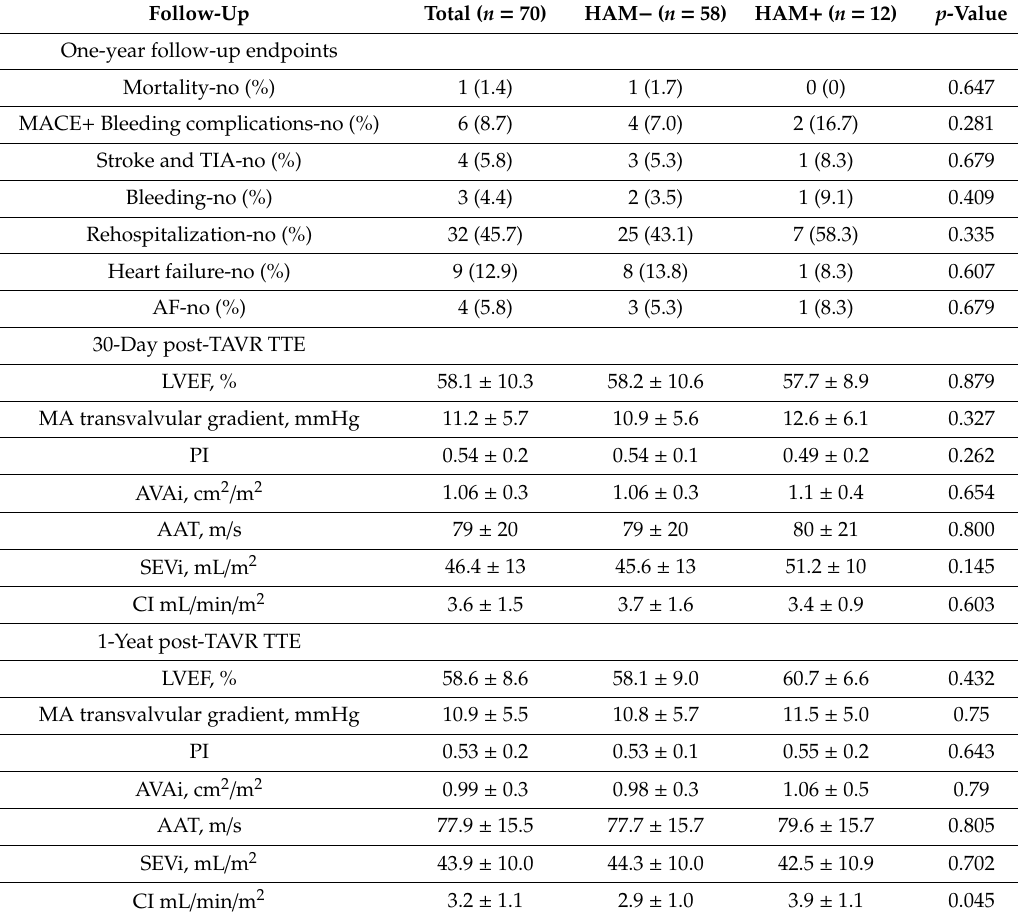
Table 5. Thirty-day TTE evaluation and one-year follow-up endpoints according to HAM occurrence.